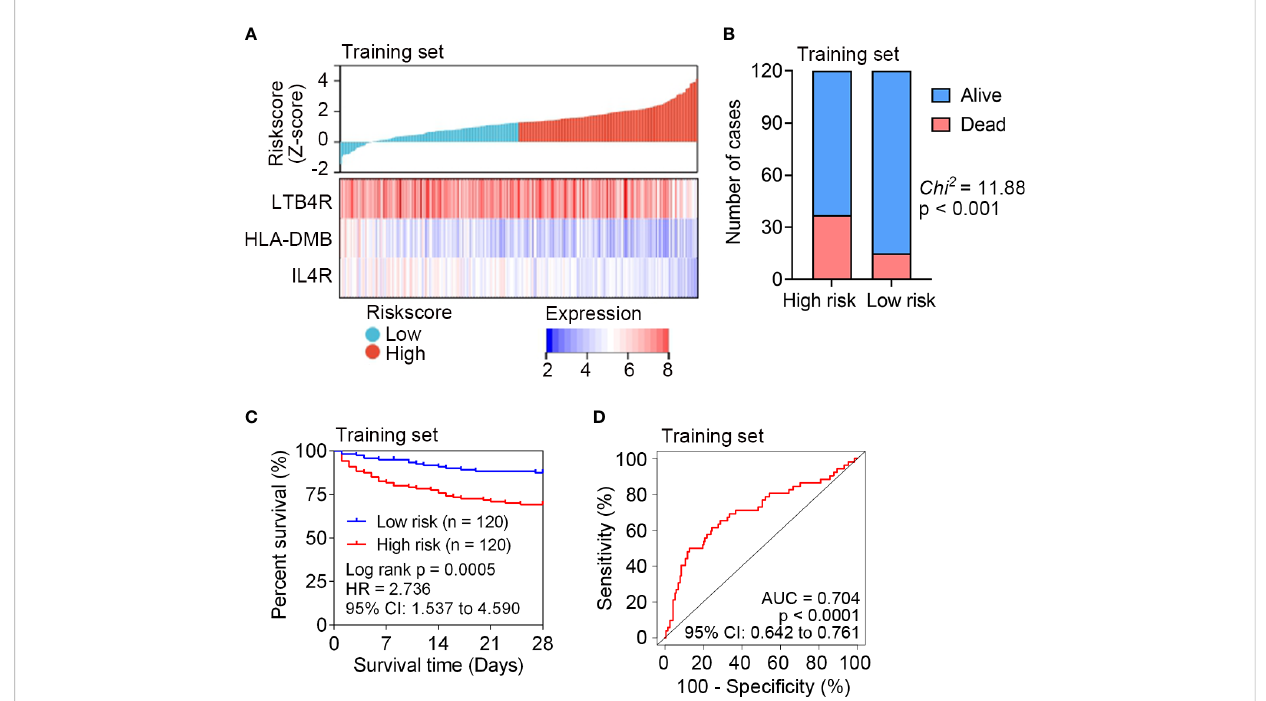
FIGURE 2 Survival analysis of the IRG signature in the training set (n = 240) of GSE65682. (A) The distribution of risk scores derived from the IRG signature, and the expression of the three genes that comprised the IRG signature in the training set of GSE65682. (B) The distribution of 28-day survival status in the high risk (n = 120) and low risk (n = 120) subgroups in the training set. Sepsis patients were divided into low risk or high risk subgroup based on the median of risk score. (C) Kaplan-Meier estimate of the 28-day survival using the IRG signature in the training set. The difference between the two curves was determined by the two-side log-rank test. (D) ROC analysis of the sensitivity and speci fi city of 28-day mortality prediction by the IRG signature in the training set. P value was obtained from the comparison of the AUC of the IRG signature risk score versus whose classi fi cation by 0.5